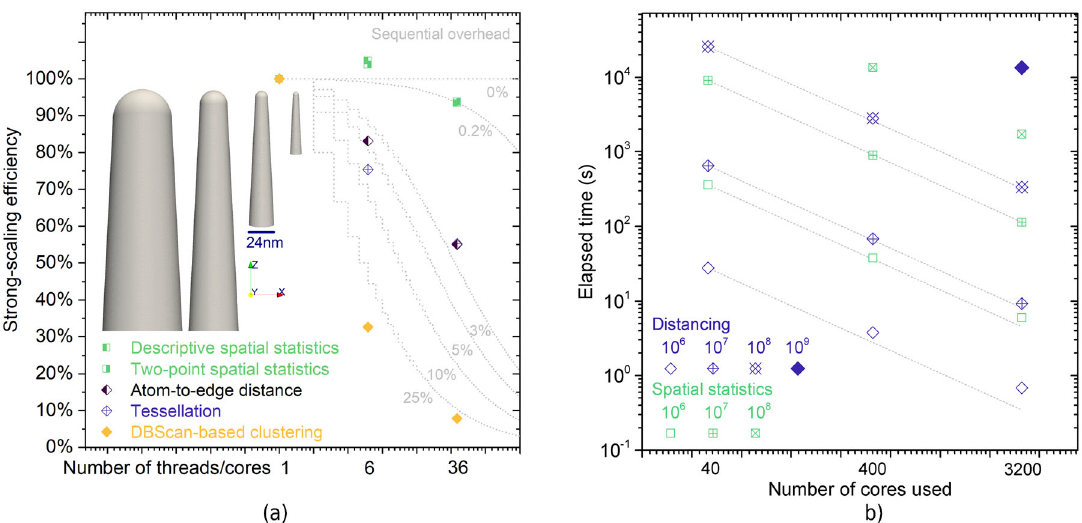
Fig. 2 We document strong-scaling ef fi ciency for multithreaded and hybrid-parallel execution. The inset in a displays the synthetic datasets. These are rendered at scale (visualized via the α -shape of the edge). For the two leftmost datasets only their upper sections are shown to retain suf fi cient pixel resolution. The gray curves in a compare the strong-scaling results for different fractions of remaining sequential overhead according to Amdahl ’ s law 100 . Sub- fi gure b reports elapsed time. The thin dashed lines compare to the theoretical optimum of linearly scaling methods. Runtime differences were within the thickness of the data point